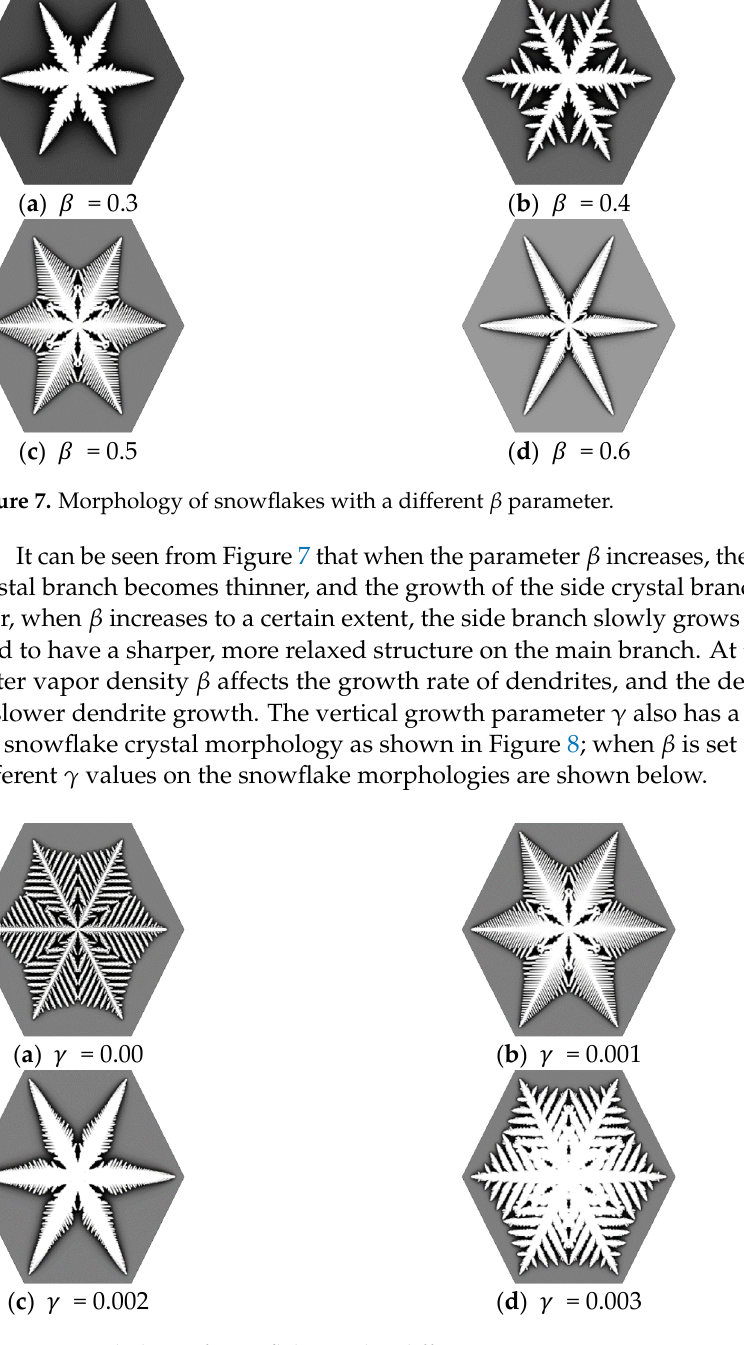
Figure 8. Morphology of snowflakes with a different γ parameter.